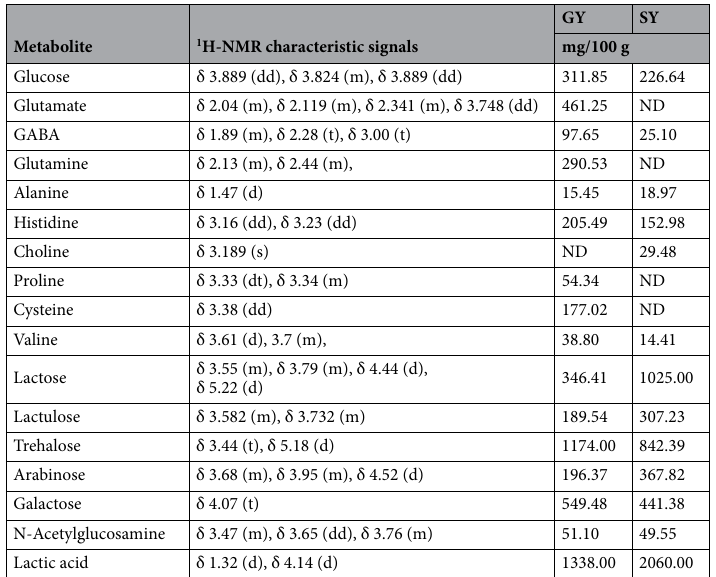
Table 1. Metabolite profiles in freeze-dried GABA-rich yoghurt (GY) and freeze-dried standard yoghurt (SY) determined using 1 H-NMR metabolomics-based analysis. s = singlet; d = doublet; t = triplet; dd = doublet of doublets; m = multiplet; ND = not